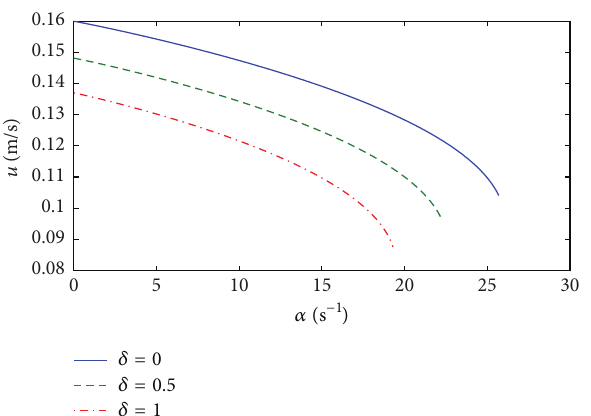
Figure 2: Influence of heat loss parameter on spray flame propa- gation velocity for different initial droplet loads—evaporation front case.